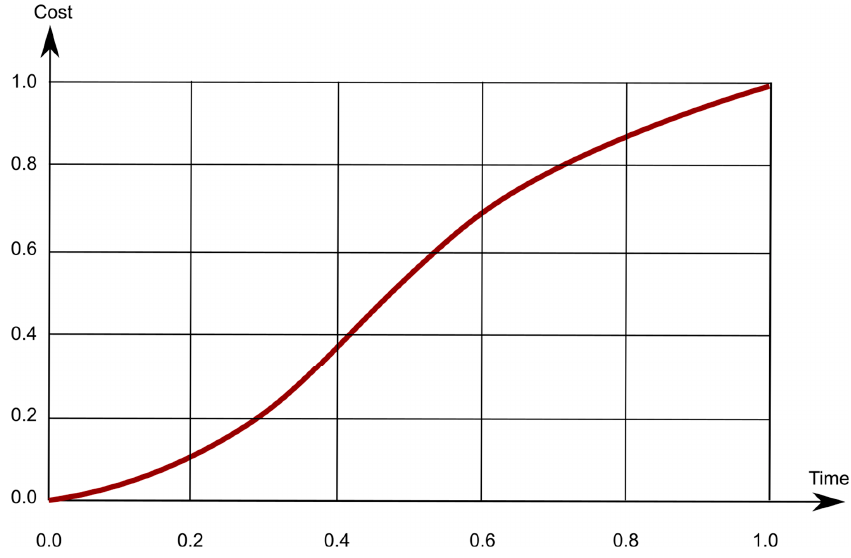
Figure 1. Model of cumulative cost curve.